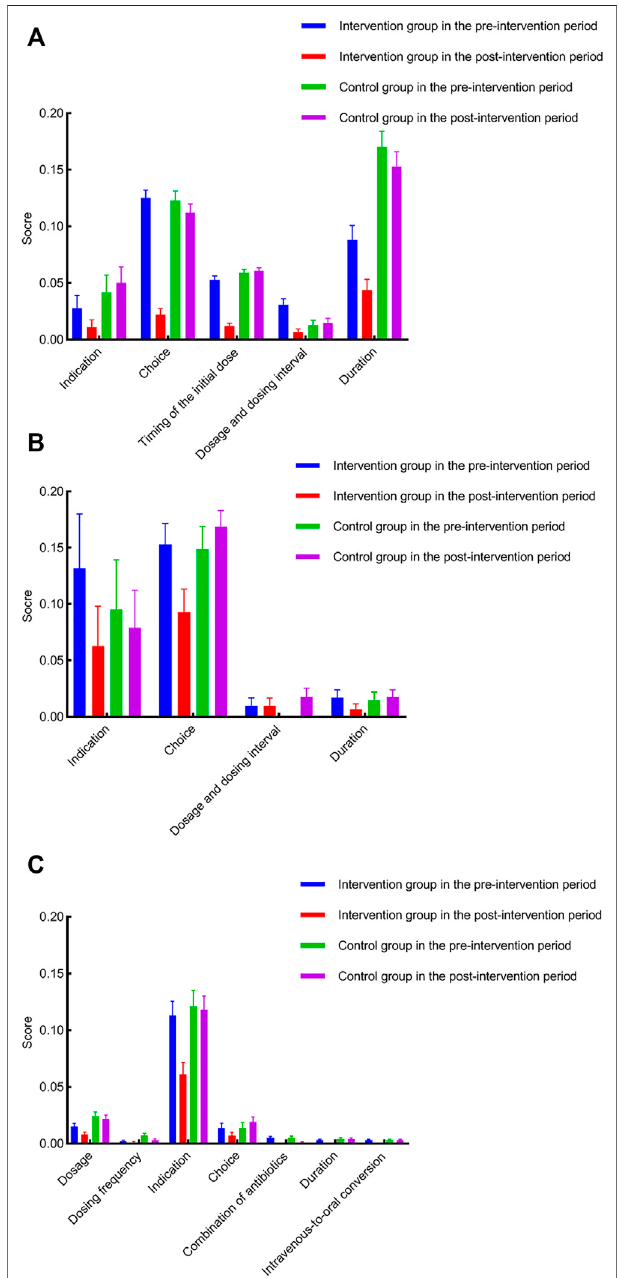
FIGURE2| Categoryanalysisforirrational useofantibacterialdrugs. (A) inappropriatescoreofantimicrobialprophylaxiswithrespecttocorresponding items for both groups during the pre- and post-intervention periods; (B) inappropriate score of non-surgical antimicrobial prophylaxis with respect to corresponding items for both groups during the pre- and post- intervention periods; (C) inappropriate score of antimicrobial treatment with respect to corresponding items for both groups during the pre- and post- intervention